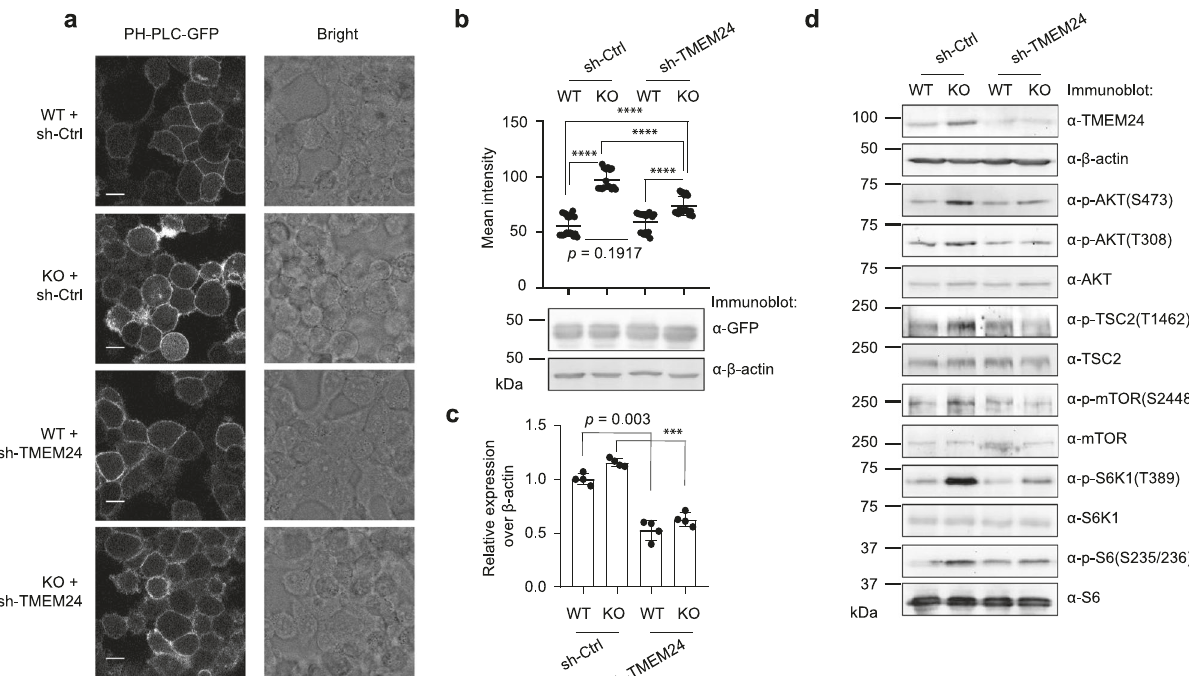
Fig. 7 Regulation of PI3K – AKT-mTOR pathway by alt-RPL36 requires its interaction with TMEM24. a PH-PLC-GFP reporter was stably introduced into the following cell lines: HEK 293T cells stably expressing control shRNA (WT + sh-Ctrl), alt-RPL36 KO cells stably expressing control shRNA (KO + sh- Ctrl), HEK 293T stably expressing TMEM24 shRNA (WT + sh-TMEM24), alt-RPL36 KO stably expressing TMEM24 shRNA (KO + sh-TMEM24). Confocal imaging was performed with live cells. Scale bar, 10 µ m. Data are representative of three biological replicates. b Top: quantitation of the PH-PLC- GFP signals in the four cell lines described above. At least 16 fi elds of view were analyzed, totaling >300 cells for each measurement. Data represent mean values ± s.e.m., and signi fi cance was evaluated with two-tailed t -test. **** p < 0.0001. Source data are provided as a Source data fi le. Bottom: western blot of the four cell lines with antibodies indicated on the right for comparison of PH-PLC-GFP expression. Data are representative of three biological replicates. c Quantitative RT-PCR with primers speci fi c to TMEM24 to assess ef fi ciency of silencing by sh-TMEM24 (error bars, standard error of the mean (s.e.m.), N = 4 biologically independent samples, *** p < 0.001 (two-tailed t -test)). Source data are provided as a Source data fi le. d Western blot analysis of the four cell lines described above with antibodies indicated on the right. Data are representative of three biological